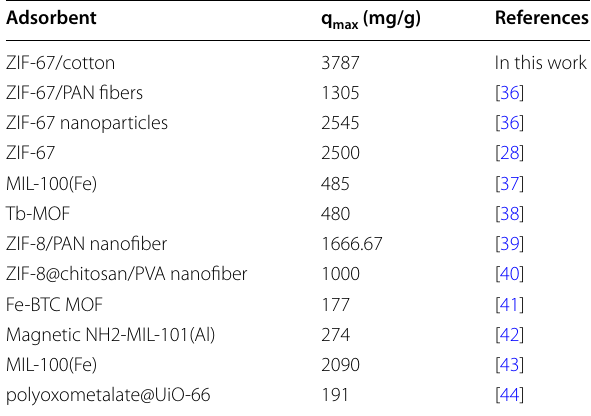
Table 2 Comparison of the adsorption capacity of the ZIF-67/ cotton fibers towards MG with other